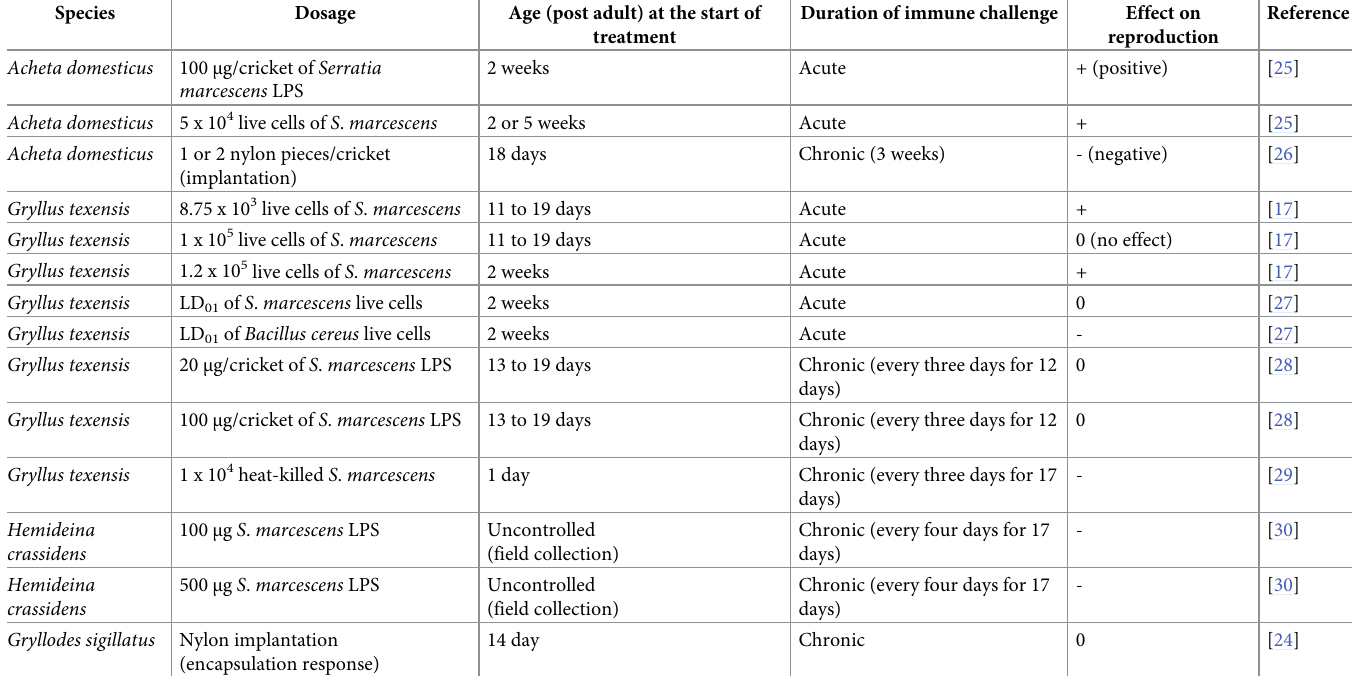
Table 1. Effect of immune challenge on reproduction in female